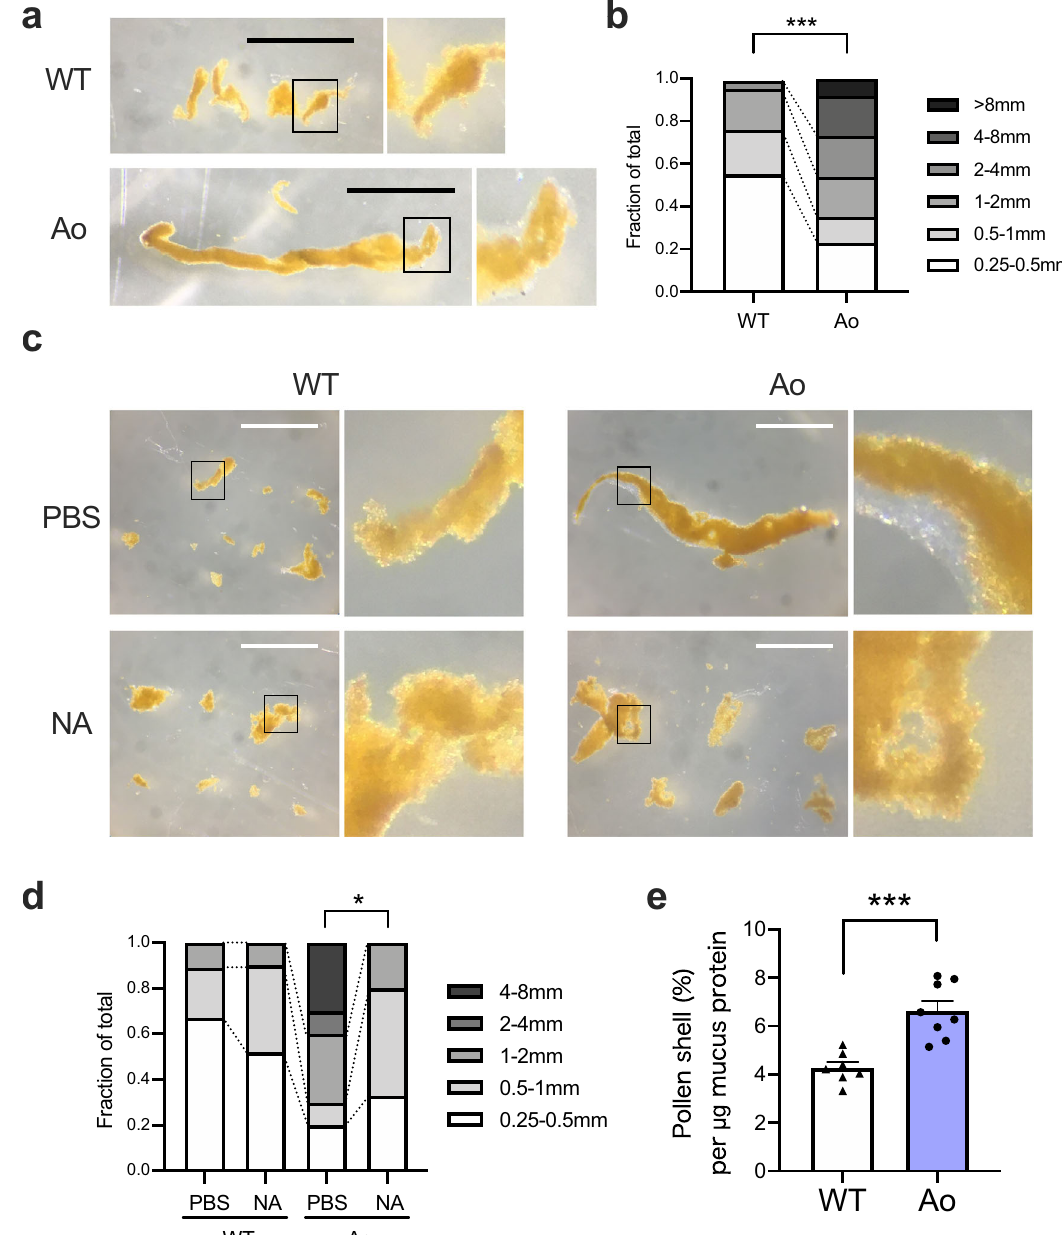
Fig. 6 | Sialylation is required for the ef fi cient entrapment of pollen shells. a Representativepictureofpollenshell-mucusaggregatesfromoneeye.Bar,1mm. b Frequencies of aggregates with indicated lengths. Pooled data from 8 eyes each. *** p <0.001 ( p =0.0009) by two-tailed Fisher ’ s exact test for the ratio of fractions <1mm and ≧ 1mm. c The pollen shells were instilled into eyes with or without 5U/ mL neuraminidase. Bar, 1mm. d Frequencies of aggregates with indicated lengths.